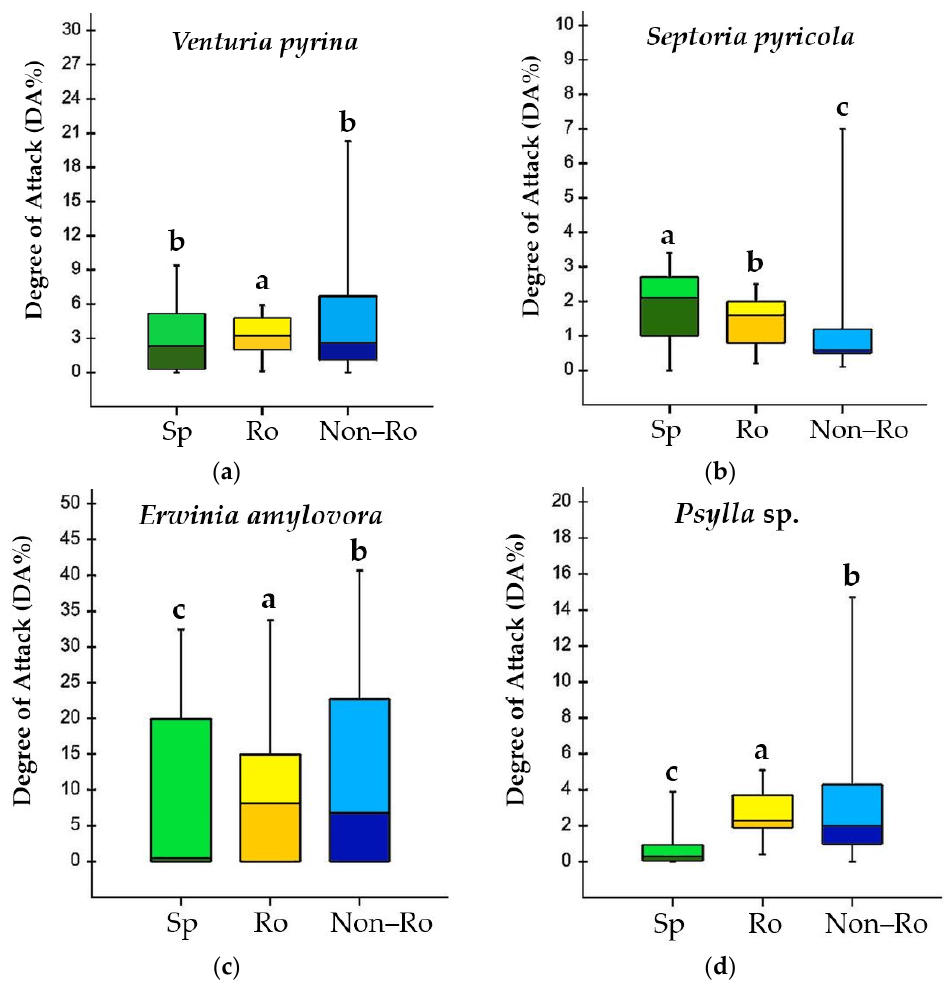
Figure 1. Degree of attack ( DA %) of the main diseases and pests: ( a ) pear scab ( V. pyrina ); ( b ) septoria ( S. pyricola ); ( c ) fi re blight ( E. amylovora ); and ( d ) psylla ( Psylla sp.). Synthesis of data as boxplots for 13 species (Sp), 17 Romanian cultivars (Ro), and 50 non-Romanian cultivars (Non- Ro). Different letters between groups of genotypes in each boxplot indicate statistically significant differences for the investigated feature at a significance level of p < 0.05 (Duncan’s test).